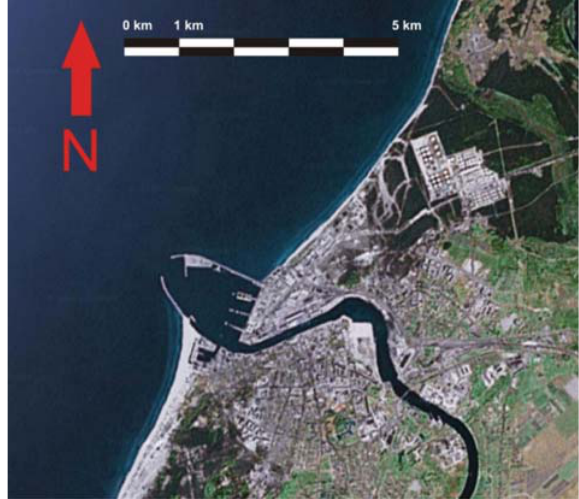
Fig. 4. Th e Port of Ventspils (Latvia)